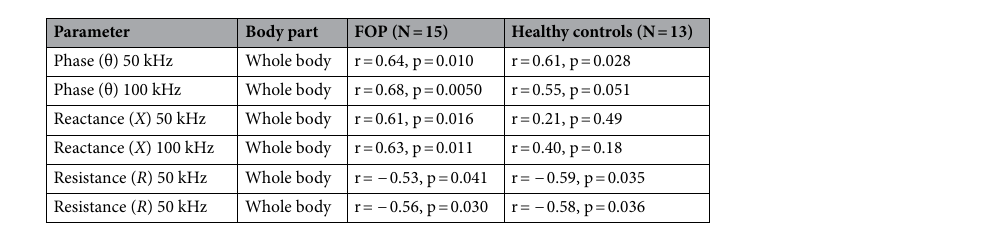
Table 3. Correlation analysis, whole-body EIM versus physical activity. Pearson’s correlation coefficients (r) and two-tailed p-values are reported.